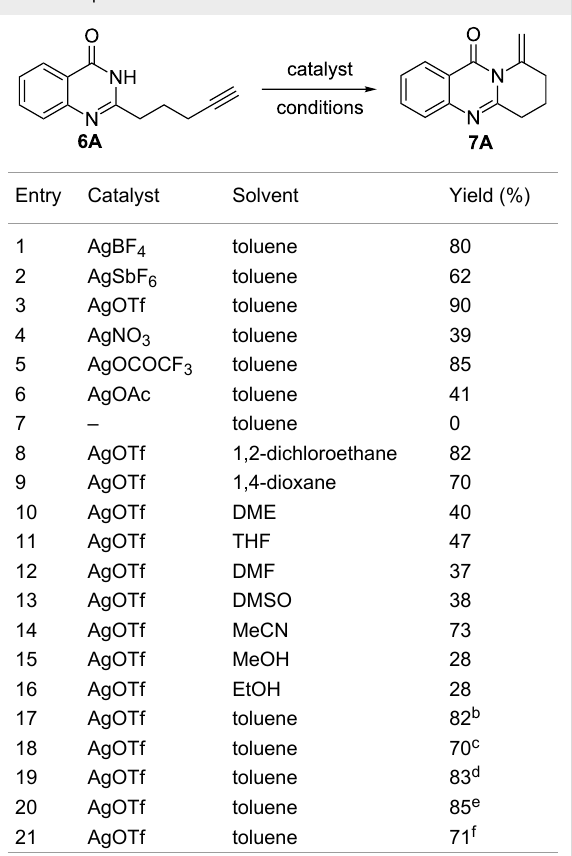
Table 1: Optimization of the reaction conditions.